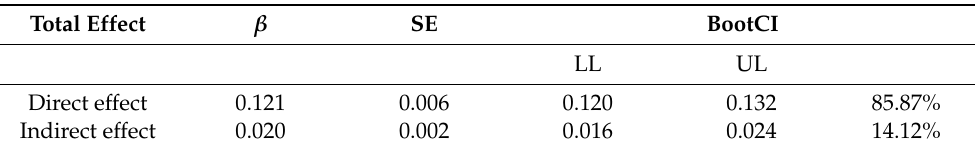
Table 3. The total effect, direct effect, and mediation effect of mentally unhealthy days on subjective aging difficulties and